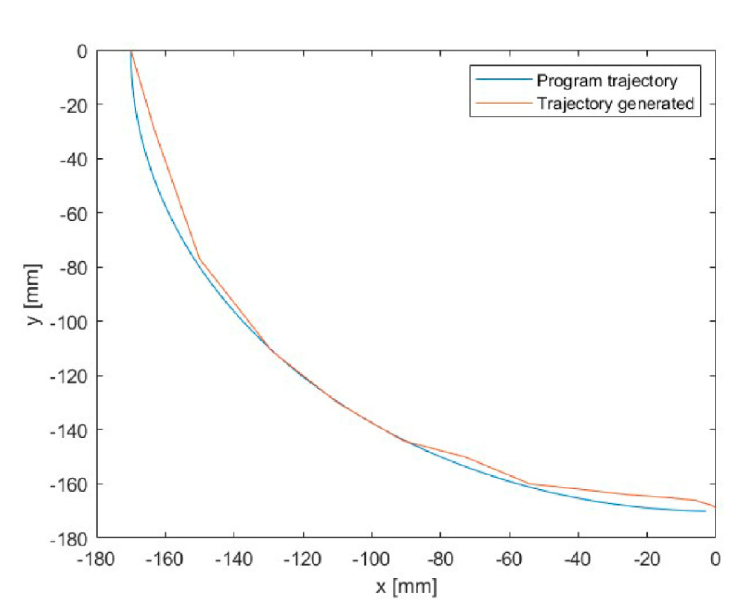
Figure 15. Compares between the program trajectory and the trajectory generated by the EE.